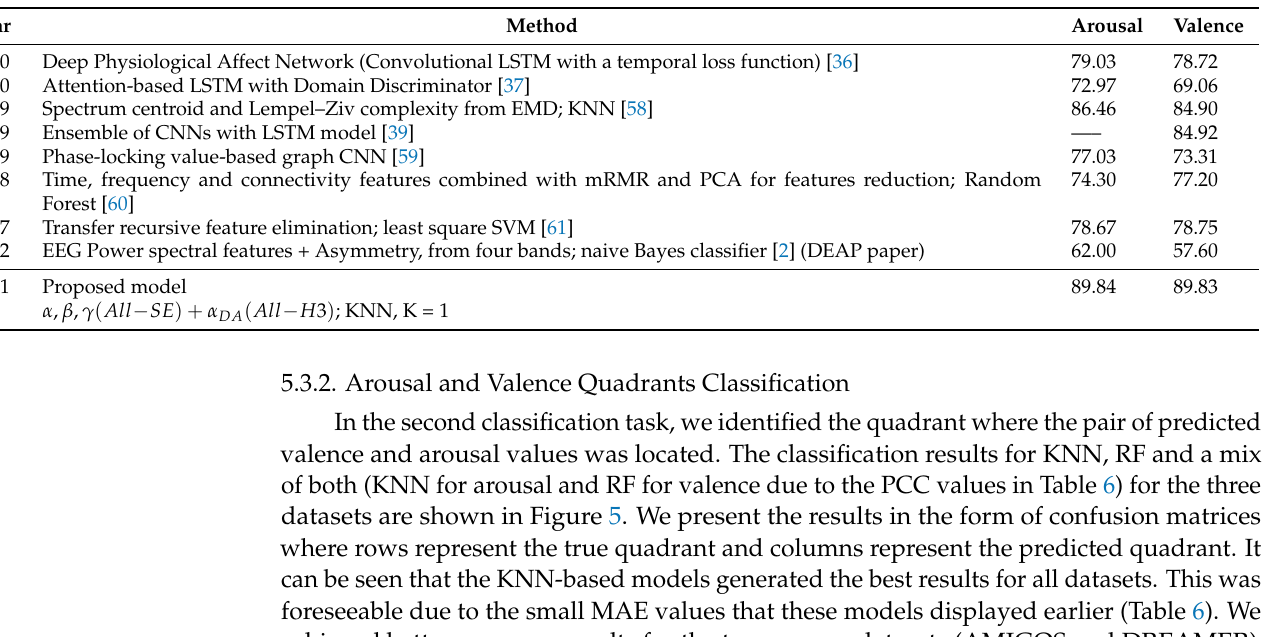
Table 9. Comparison of the accuracy (%) of the proposed model with previous works, for arousal and valence binary classification (low/high arousal, low/high valence). Values are from the original papers and using the DEAP dataset.